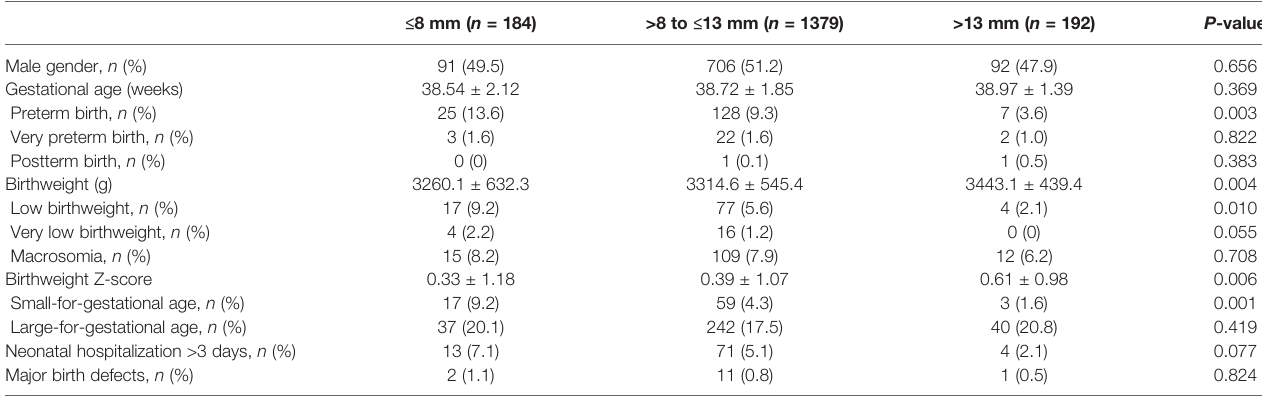
TABLE 3 | Neonatal outcomes grouped by endometrial thickness.